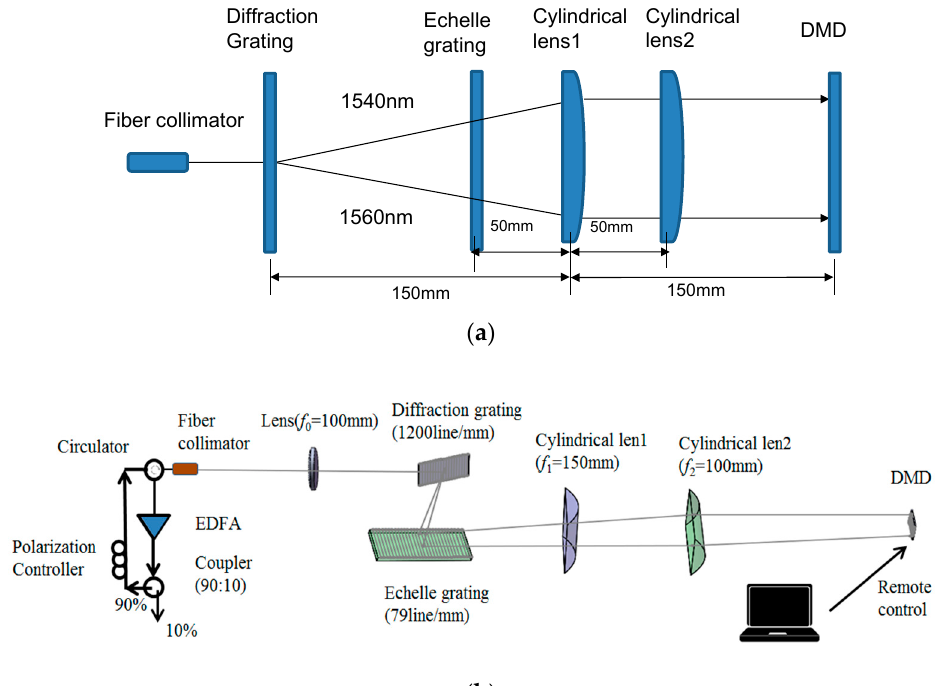
Figure 3. ( a ) Diagram of a cross-dispersion tunable laser system. ( b ) Layout of wavelength selective path.